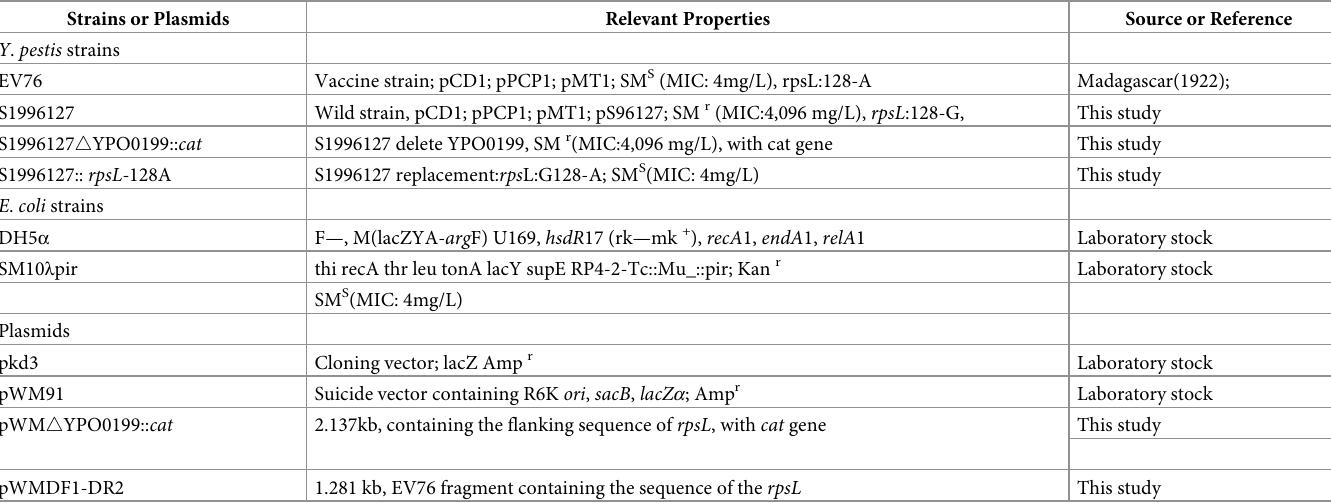
Table 1. The Strains and Plasmids Used in this Study. Strains or